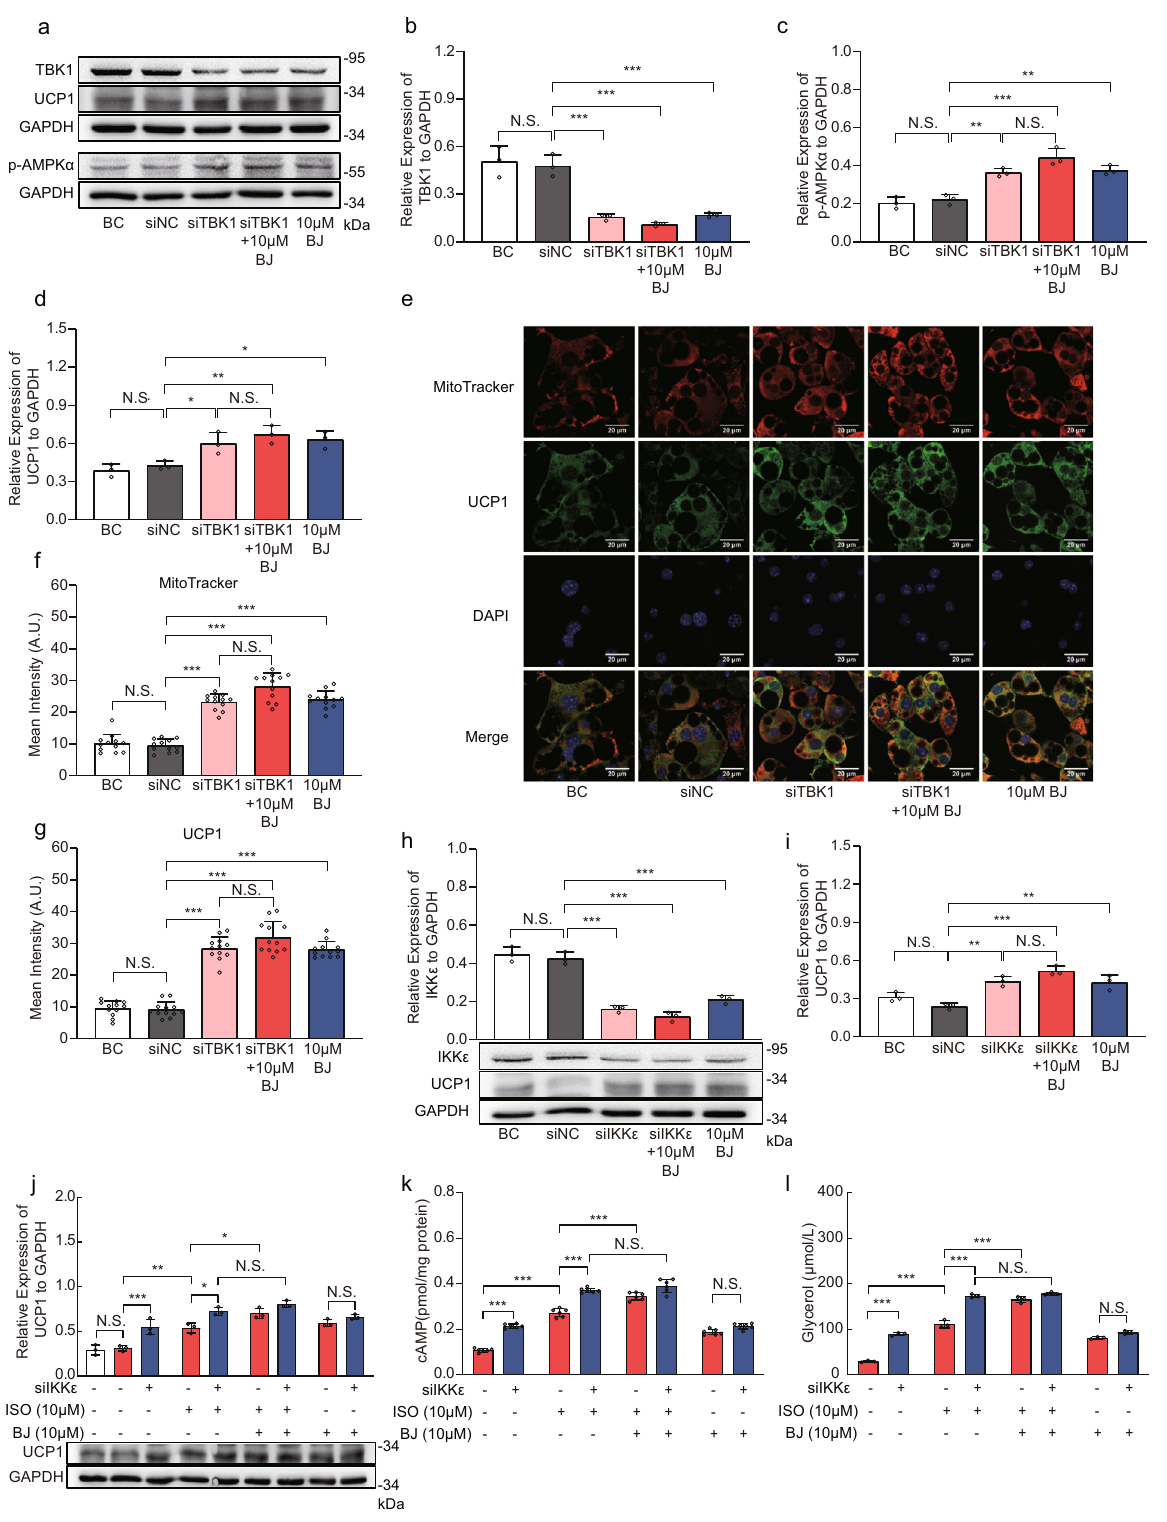
Fig. 9 BJ targets TBK1 and IKK ε to regulate 3T3-L1 adipocytes. a – d Relative protein levels of TBK1, p-AMPK α and UCP1 in TBK1-knockdown 3T3-L1 adipocytes treated with or without BJ. e – g Immuno fl uorescence staining of UCP1 (green), MitoTracker (red), and DAPI (blue) in TBK1-knockdown 3T3-L1 adipocytes treated with or without BJ (scale bar = 20 µ m). h , i Relative protein levels of IKK ε and UCP1 in IKK ε -knockdown 3T3-L1 adipocytes treated with or without BJ. j Relative protein levels of UCP1 in IKK ε -knockdown 3T3-L1 adipocytes treated with ISO or BJ. k , l Measurement of cAMP levels ( k ) and Glycerol release ( l ) in IKK ε -knockdown 3T3-L1 adipocytes treated with ISO or BJ. Data are expressed as mean ± SD. NS not signi fi cant, * P < 0.05, ** P < 0.01, *** P <